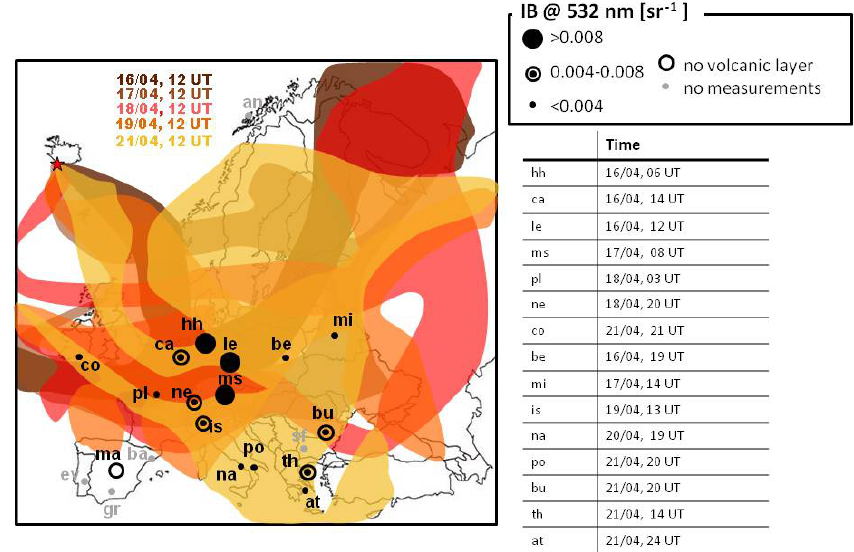
Fig. 11. Map of Europe showing the dispersion of the Eyjafjallaj¨okull (red star) volcanic aerosol plume during the first week after the major eruption on 14 April 2010. The approximate location of the plume in the 3–5km height range is given for 12:00 UT on 16 April (dark brown), 17 April (light brown), 18 April (red), 19 April (orange), and 21 April 2010 (yellow). The maximum integrated backscatter (IB) at 532nm measured by each station is reported in black. The exact time location of the maximum IB reported is reported in the legend.